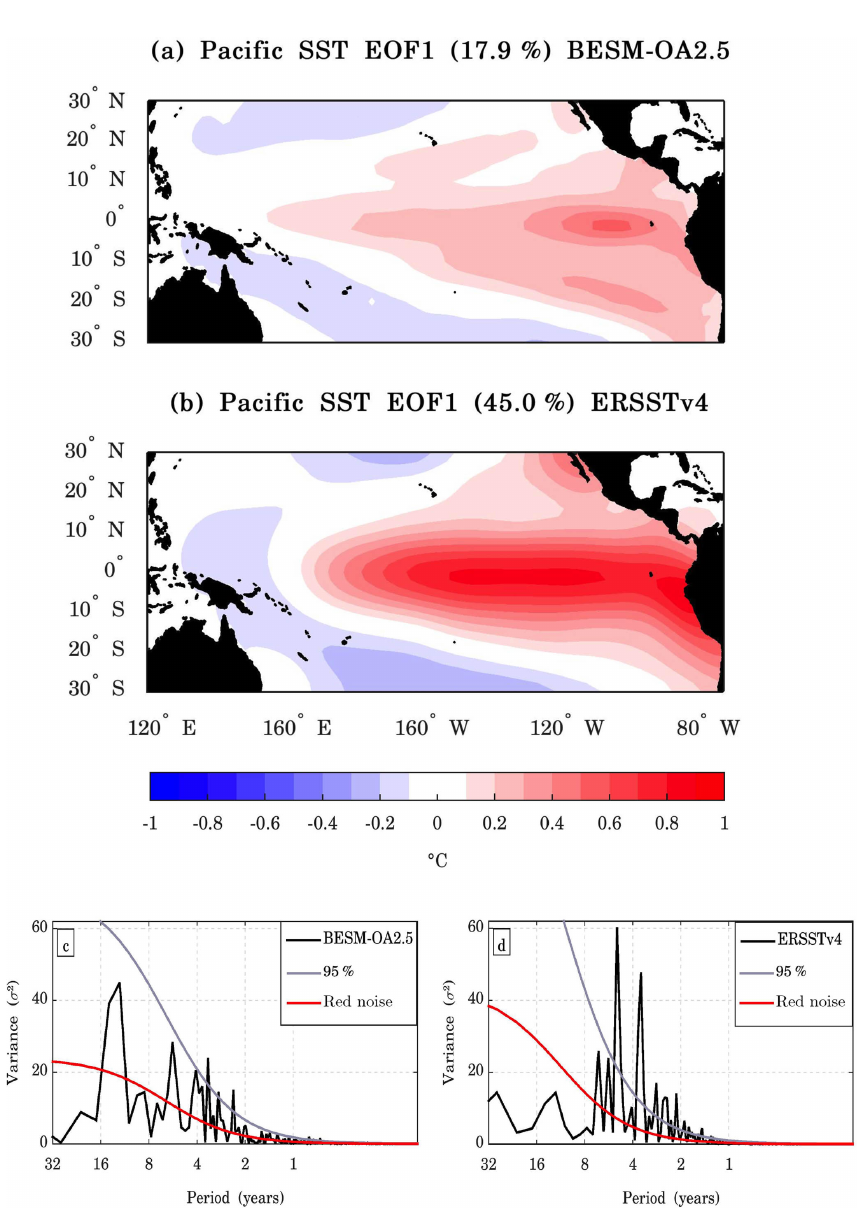
Figure 16. The leading EOF modes of the detrended monthly SST anomalies over the tropical Pacific region (30 ◦ S–30 ◦ N, 240–70 ◦ W) for (a) BESM-OA2.5 and (b) ERSSTv4. The results are shown as the SST anomalies regressed onto the corresponding normalized PC time series (degrees Celsius per standard deviation) over the period 1950–2005. The percentages of the variance explained by each EOF are indicated in the titles of the panels. The contour interval is 0.1 ◦ C. Panels (c) and (d) show the power spectra of the leading joint PC time series of the patterns for BESM-OA2.5 and ERSSTv4, respectively. The solid red line represents the theoretical red noise spectrum and the gray line represents the 95% confidence